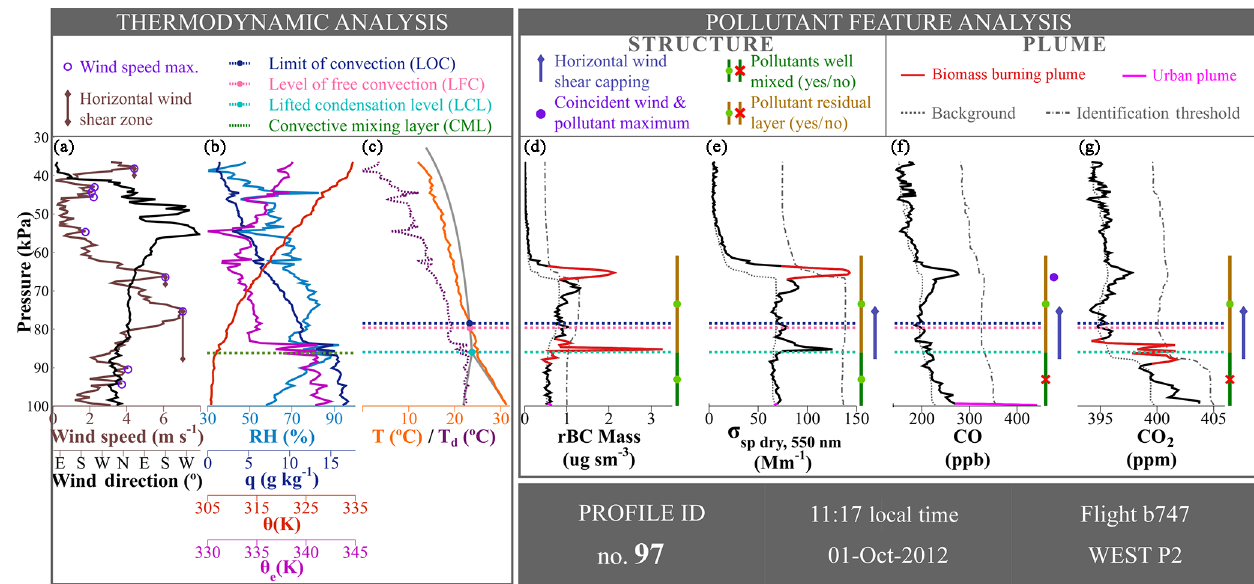
Figure 3. Individual profile no. 97, from flight b747 (1 October 2012) near Porto Velho in Rondônia state. From left to right are the vertical profiles of (a) wind speed and direction, (b) relative humidity (RH), specific humidity ( q ), potential temperature ( θ ) and equivalent potential temperature ( θ e ), (c) temperature ( T ) and dew point temperature ( T d ) on a skew-T log-P scale, (d) refractory black carbon (rBC) mass, (e) aerosol scattering coefficient (550nm), (f) CO and (g) CO 2 mixing ratios. Thermodynamic features are illustrated in panels (a)–(c) (see Sect. 3.1). Pollutant feature analysis is illustrated in panels (d)–(g) (see Sect. 3.2). Note that the red outline of a biomass burning plume is only present if it was identified for that specific species. For example, at 65kPa rBC and σ sp_dry pass the identification threshold (dotted-dashed grey line) but CO and CO 2 do